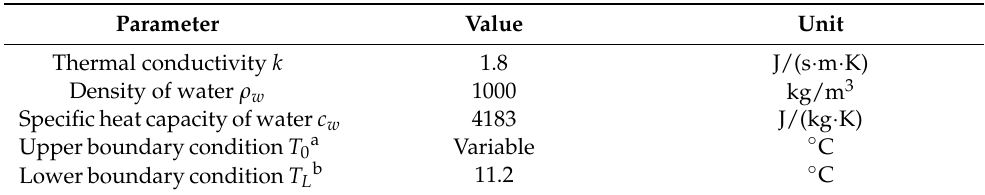
Table 1. Physical properties and boundary conditions that are used to solve the analytical solution of Bredehoeft and Papadopulos